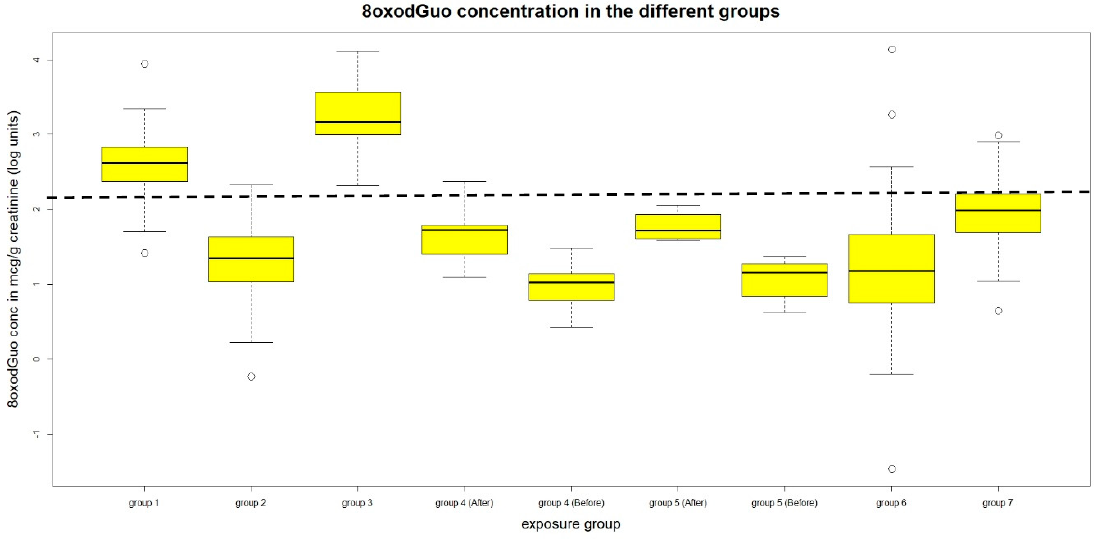
Figure 3. Urinary concentrations of 8-oxodGuo.